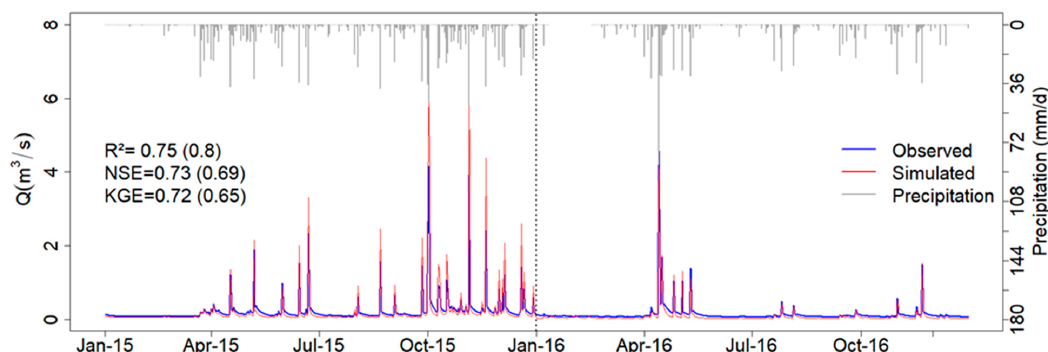
Figure 3. Daily observed and simulated discharge for the calibration (2015) and validation (2016) periods at the catchment outlet. Statistical measures are shown in the graph. R 2 is the coefficient of determination, KGE is the Kling-Gupta efficiency and NSE is the Nash-Sutcliffe efficiency. The parentheses values are for the validation period (Figure modified after [31]).